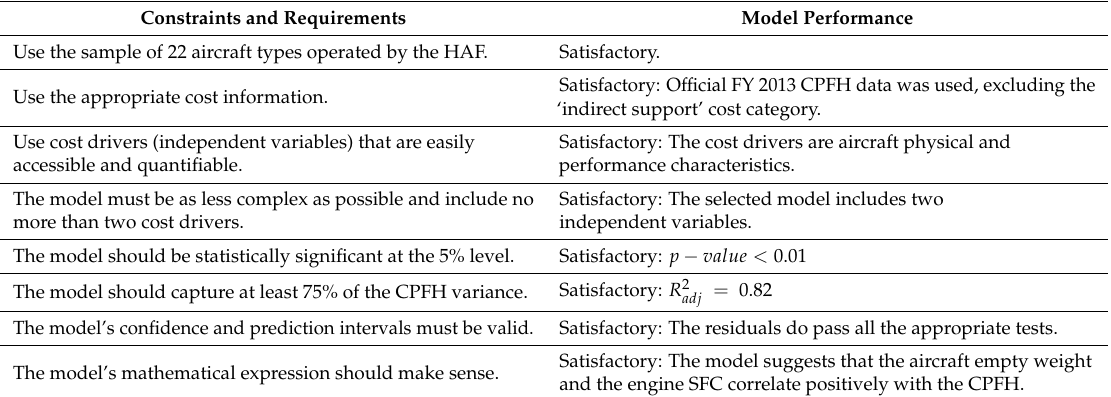
Table 2. Generic view of the constraints/requirements and the parametric model performance. Constraints and Requirements Model Performance